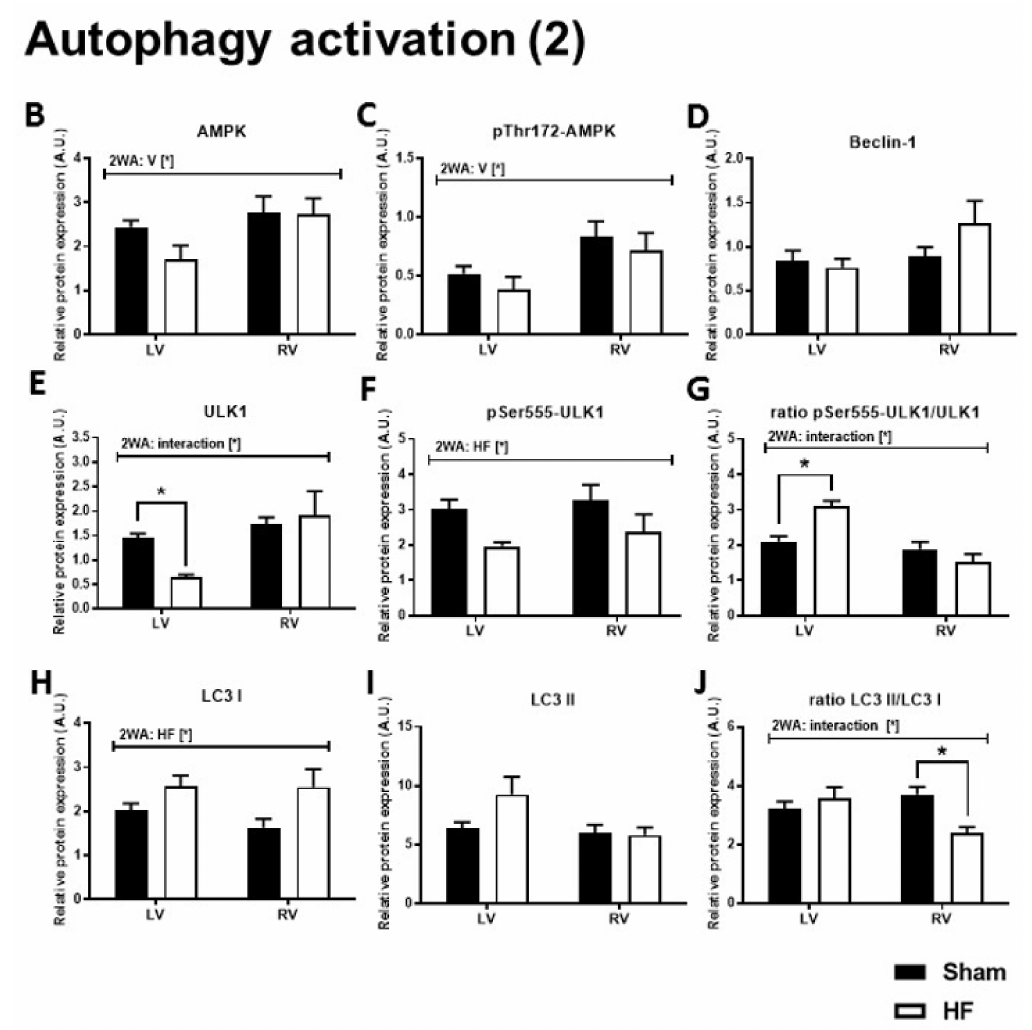
Figure 2. Analysis of activation of autophagic signaling in the left and right ventricle of rat hearts. ( A ) representative immunoblots and total protein staining; ( B – J ) Immunoblot quantification of AMPK, pThr172-AMPK, Beclin-1, ULK1, pSer555-ULK1, ratio pSer555-ULK1 / ULK1, LC3-I, LC3-II, ratio LC3-II / LC3-I. Sham—sham-operated group; HF—group with post- myocardial infarction heart failure; LV—left ventricle; RV—right ventricle. Data are presented as mean ± SEM; n = 6–9 per group; 2WA—2-way ANOVA; “HF” factor—presence of heart failure; “V” factor—heart ventricle; “Interaction” of 2 factors. * p < 0.05 vs.